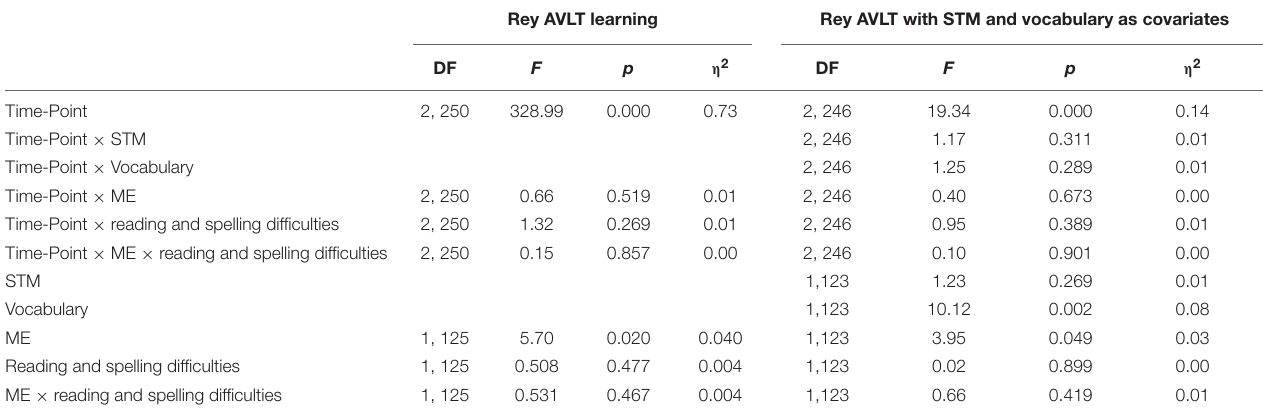
TABLE 5 | Analyses of the verbal word-learning